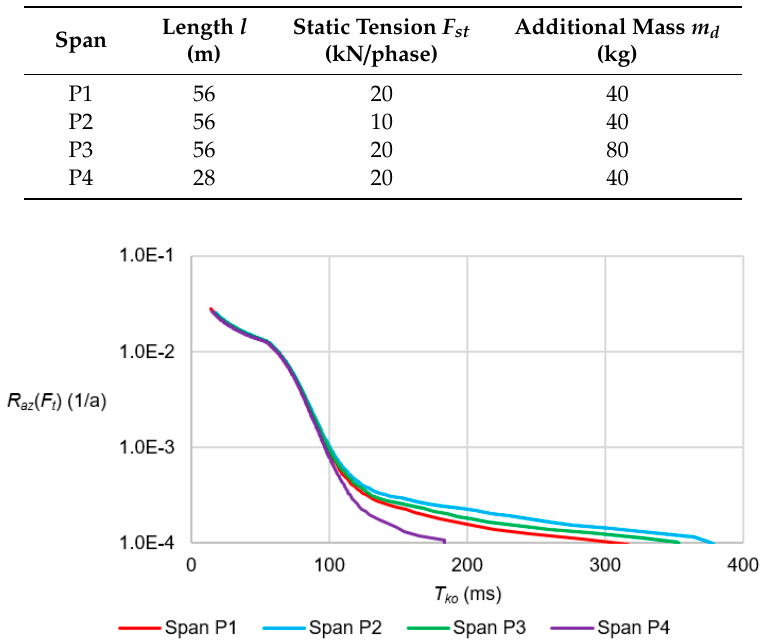
Table 8. Force F t values and corresponding T ko values for defined risk levels and di ff erent values of protection and circuit-breaker failure rates; fault conditions at point A.